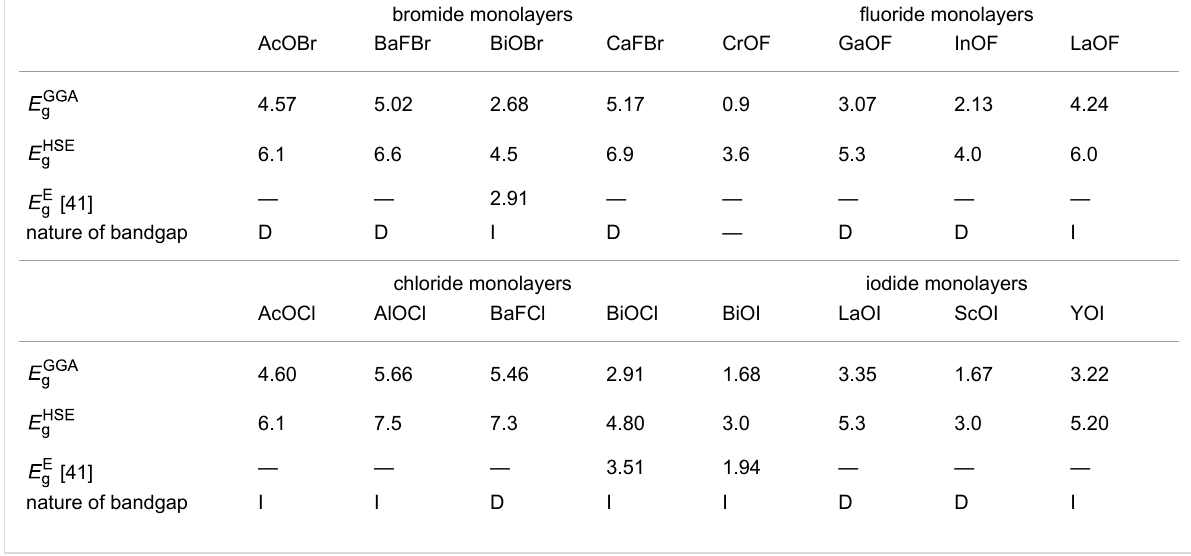
Table 2: Comparison of theoretical bandgap energy E g (eV) of different monolayers with experimental values (